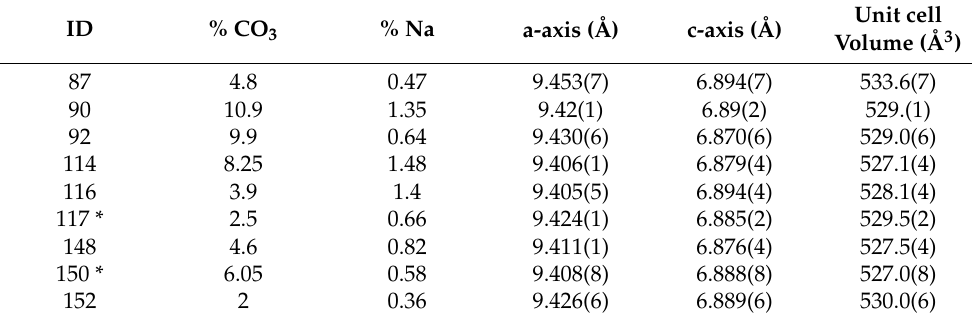
Figure 6. The carbonate ν 3 regions of the IR spectra of (in order of increasing intensity in the figure)): KS-87, 90, 92, 114, 116, 148, 152. Table 5. Lattice